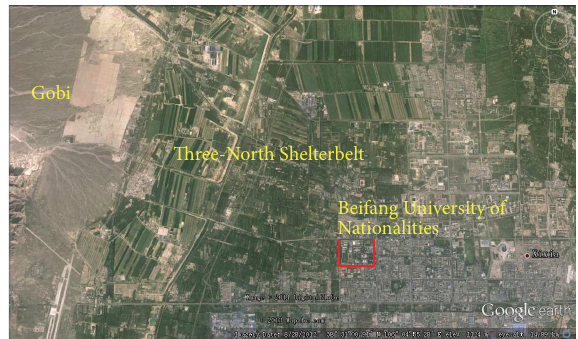
Figure 2: The campus location in Yinchuan.